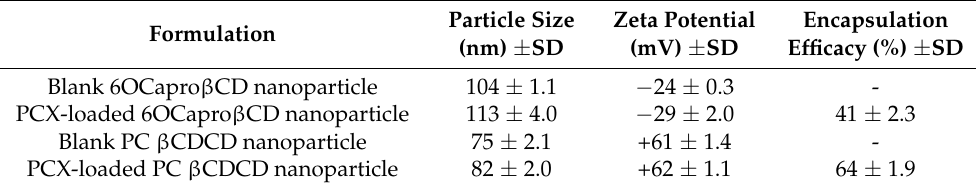
Table 1. Physicochemical properties of blank or paclitaxel-loaded amphiphilic cyclodextrin nanopar- ticles (n = 3, ± SD)